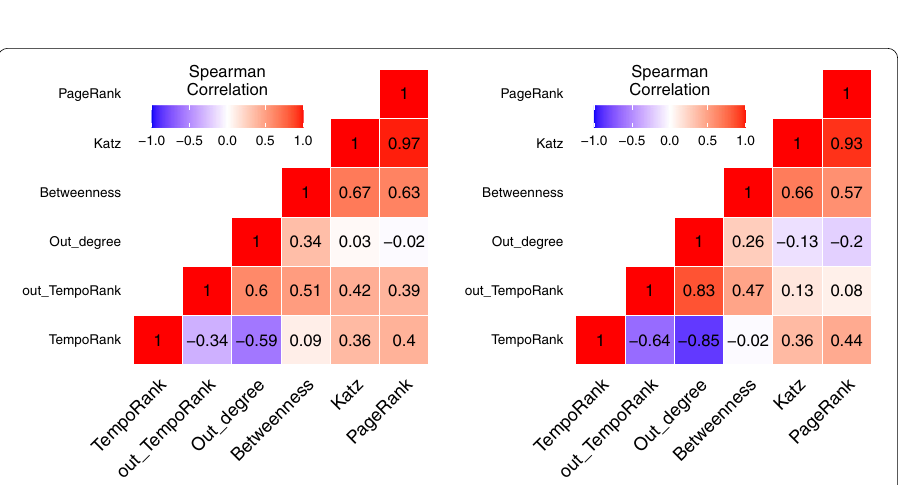
Fig. 4 Spearman correlation coefficients between static and temporal centrality measures on the 2015 BDNI network, complete (left) and reconstructed